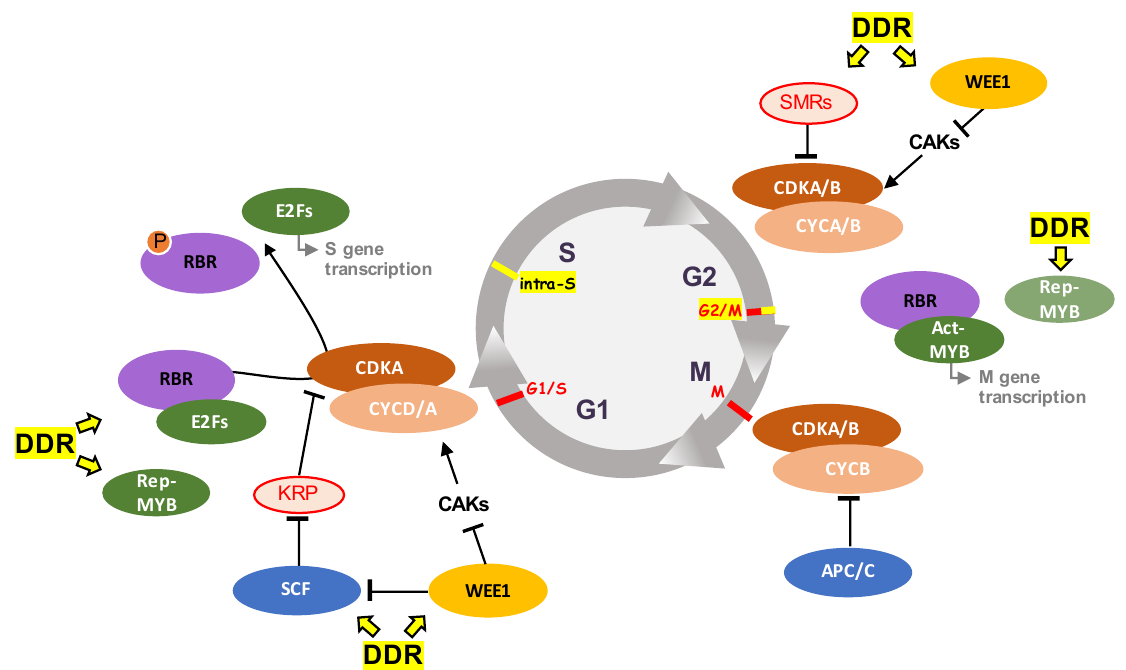
Figure 1. Schematic overview of the plant mitotic cell cycle and its connections with the DDR. Canonical checkpoints, in red, and those activated by the DDR, in yellow, are placed on the cell cycle. Upon detected DNA damage, links where the DDR signalling interfere with cell cycle players are highlighted in yellow. At the G2/M transition, the Rep-MYB TFs are mentioned in light-green as they are degraded by the UPS under normal conditions but accumulate upon DNA damage. Please refer to the core text for further